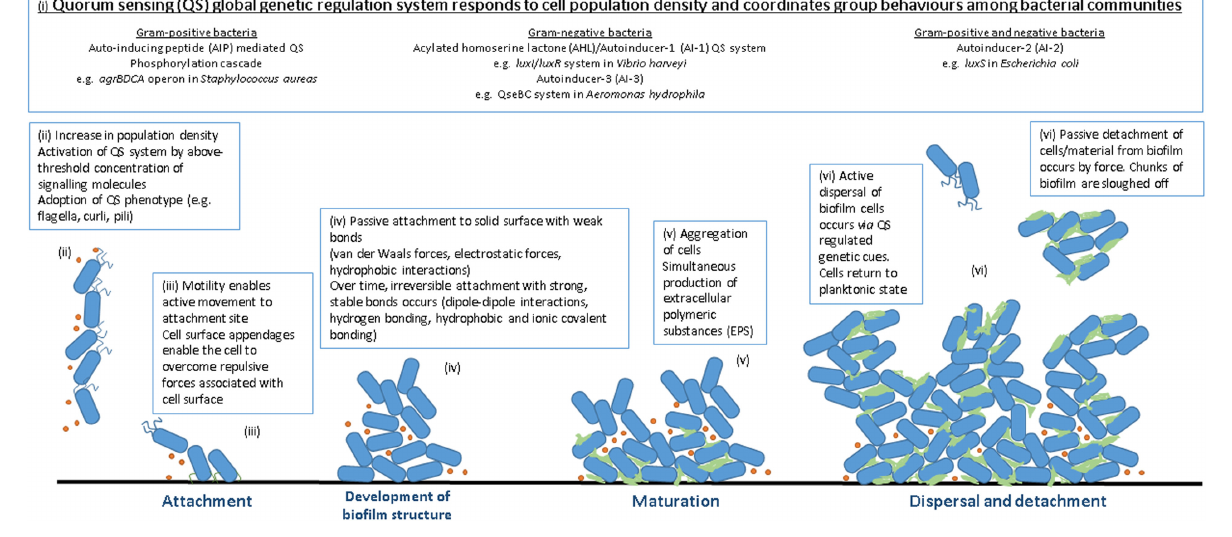
Frontiers in Microbiology |